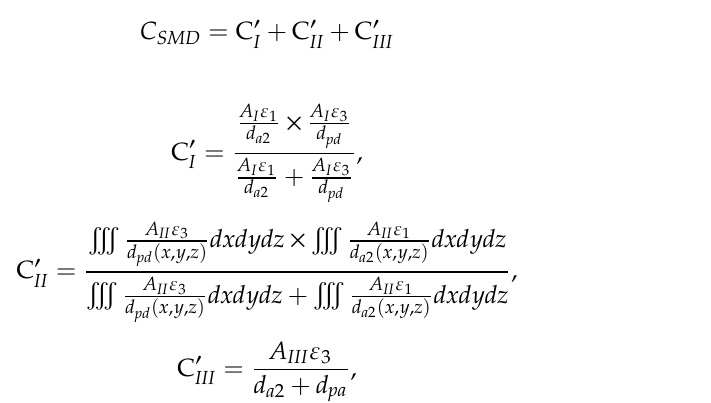
Figure 3. Illustration and capacitance calculation principle of a single unit of ( a ) SME and ( b ) SMD, where A I , A II , and A III are the electrode area of regions I, II, and III, respectively, ε 1 , ε 2 , and ε 3 the permittivity of air, parylene, and PDMS, respectively, d a 1 the thickness of air dielectric at the blank region I in SME, d a 2 the thickness of air dielectric at the blank region I in SMD, d pa the thickness of parylene layer, d pd the thickness of PDMS layer at the blank region I in SMD, d a 1 ( x,y,z ) the thickness of air dielectric at the slope region II in SME, d a 2 ( x,y,z ) the thickness of air dielectric at the slope region II in SMD, d pd ( x,y,z ) the thickness of PDMS at the slope region II in SMD. For SMD, the capacitance of a pyramid unit